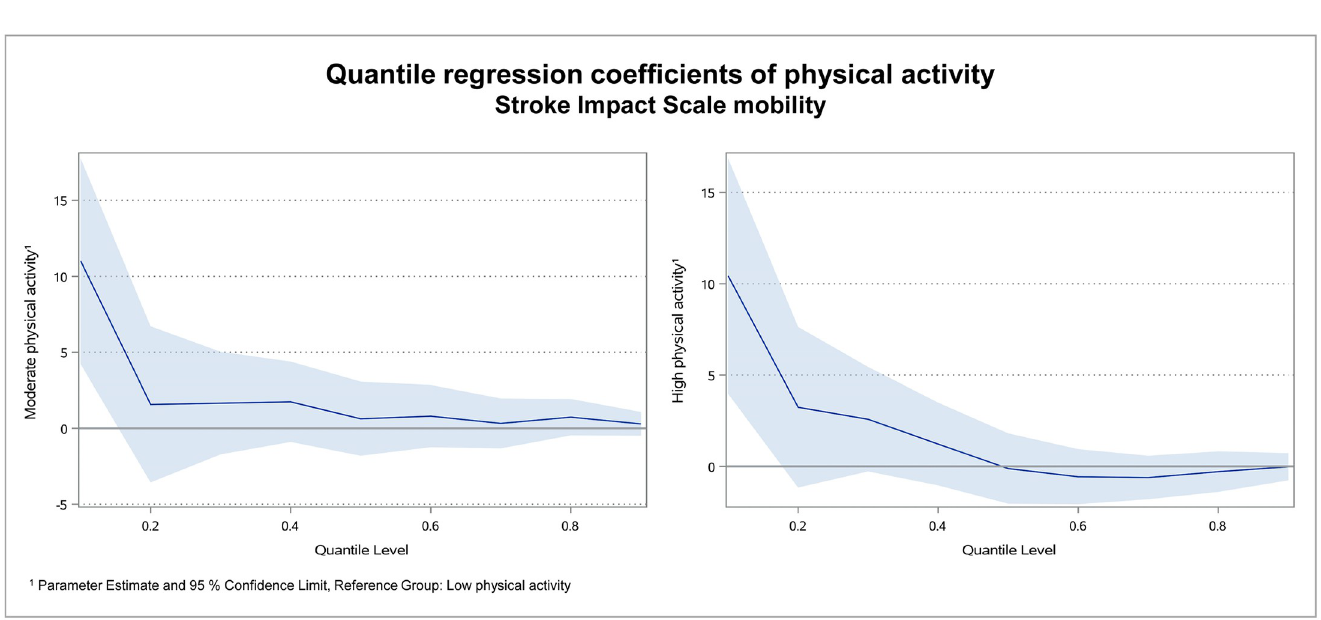
Fig 4. Quantile regression coefficients of physical activity for SIS mobility. In the subdomain mobility, the coefficient of moderate physical activity was 11.0 in quantile 0.1, while it declined to 1.7 or smaller in all other quantiles. For high physical activity it was 10.4 in quantile 0.1 and declined to 3.2 or smaller in all other quantiles. In the quantiles 0.5 to 0.9 the coefficient was slightly negative. This means, SIS scores turned out to be 11.0 points higher for moderate and 10.4 points higher for patients with high physical activity in the lowest quantile.